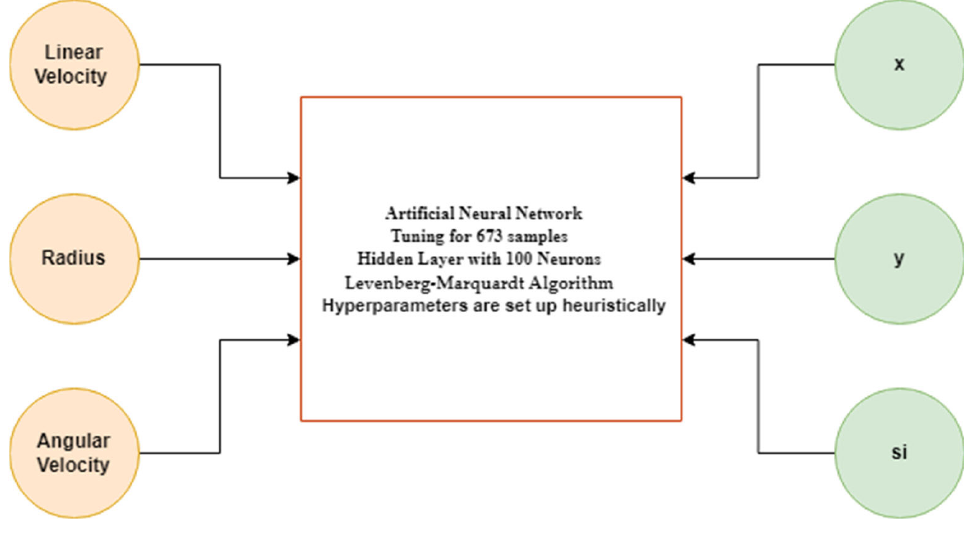
Figure 2. Schematic diagram of ANN of TWR.